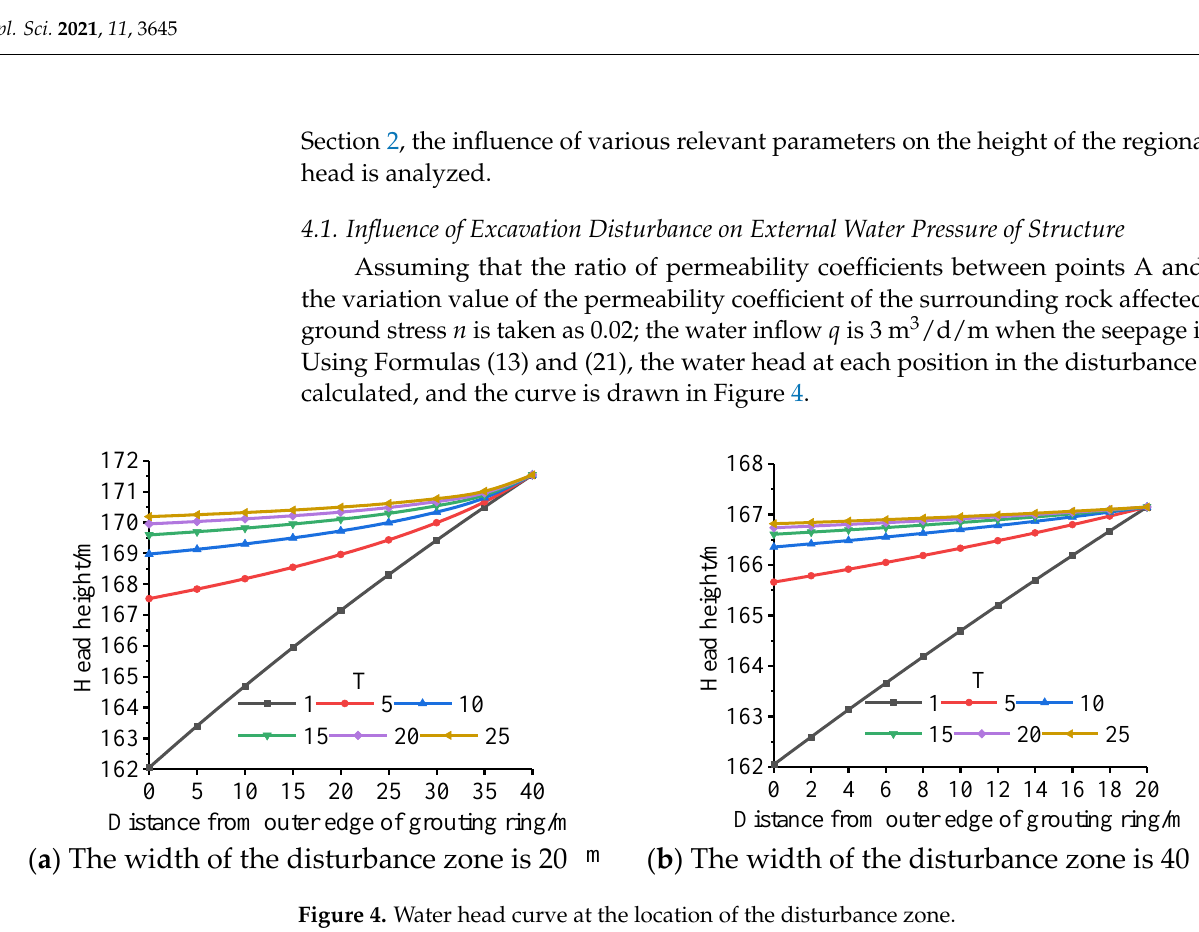
h , and the curve is shown in Figure 5. F